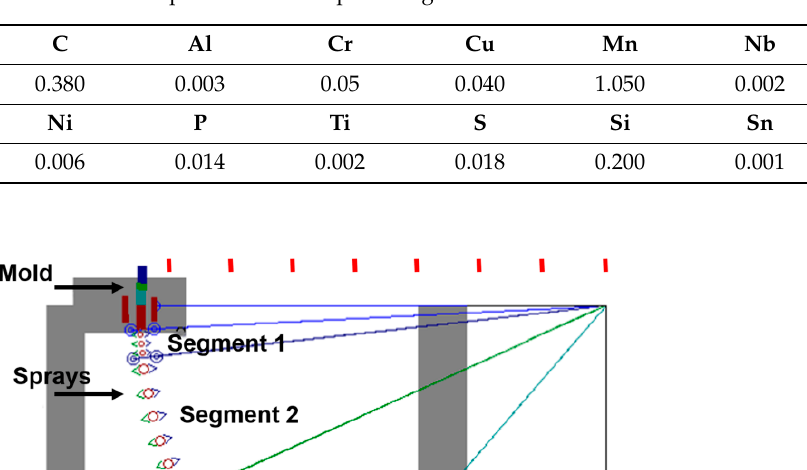
Table 3. Steel composition in mass percentage.